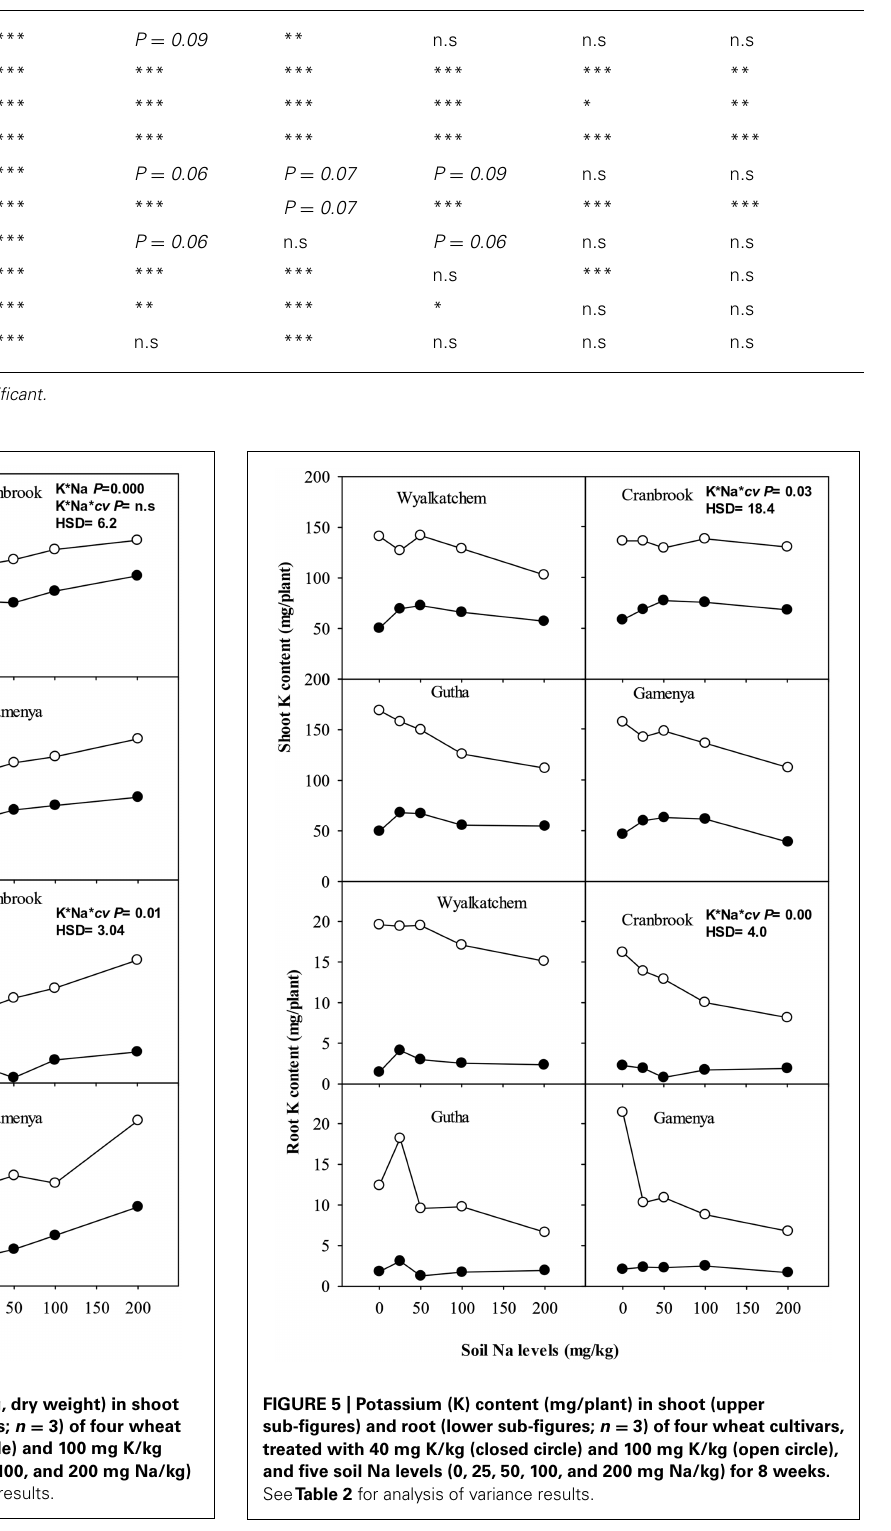
Table 2 | Statistical summary of K and Na concentrations and contents in four wheat cultivars (Wyalkatchem, Cranbrook, Gutha, and Gamenya) treated with two levels of soil K (40, 100 mg K/kg) and five levels of Na (0, 25, 50, 100, 200 mg Na/kg) for 8 weeks. Parameters Soil K Soil Na Cultivar